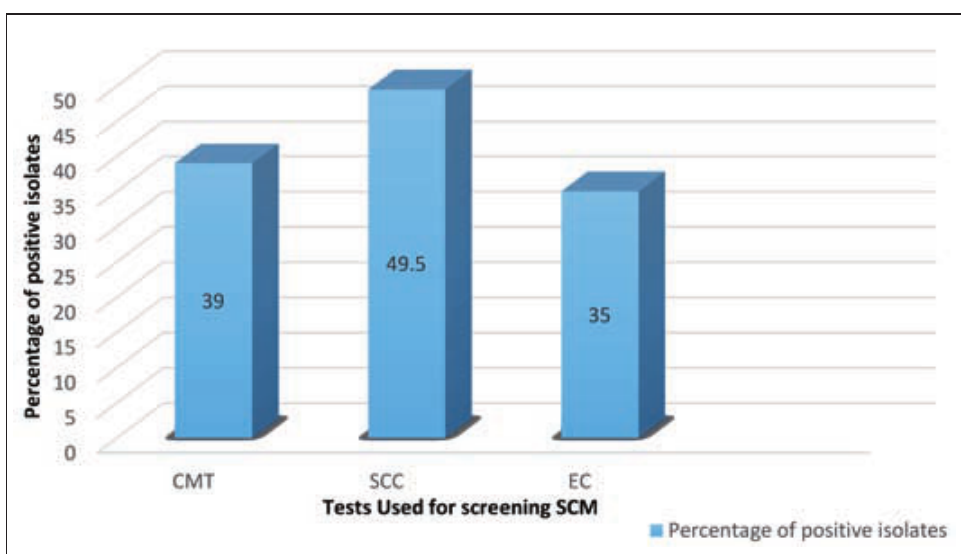
Fig. 1 Results of three diagnostic tests used for screening subclinical mastitis